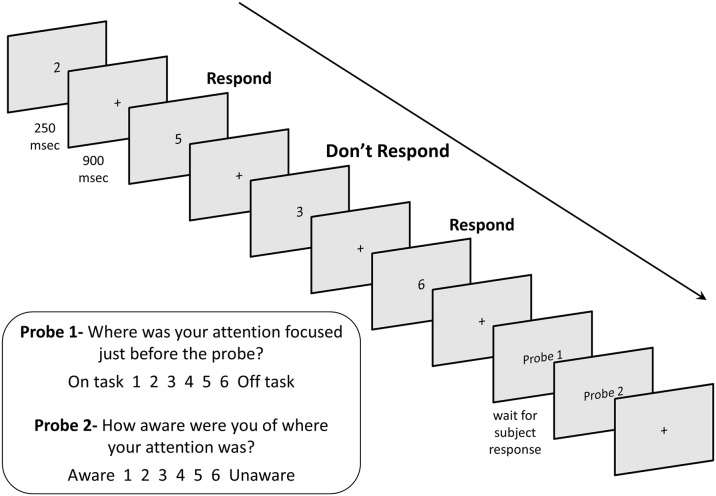
The Sustained-Attention-to-Response Task (SART).Responses were withheld from targets (the digit 3). Responses to non-targets (all other single digits) were made with the space bar. Probe 1 and 2 appeared intermittently between trials.